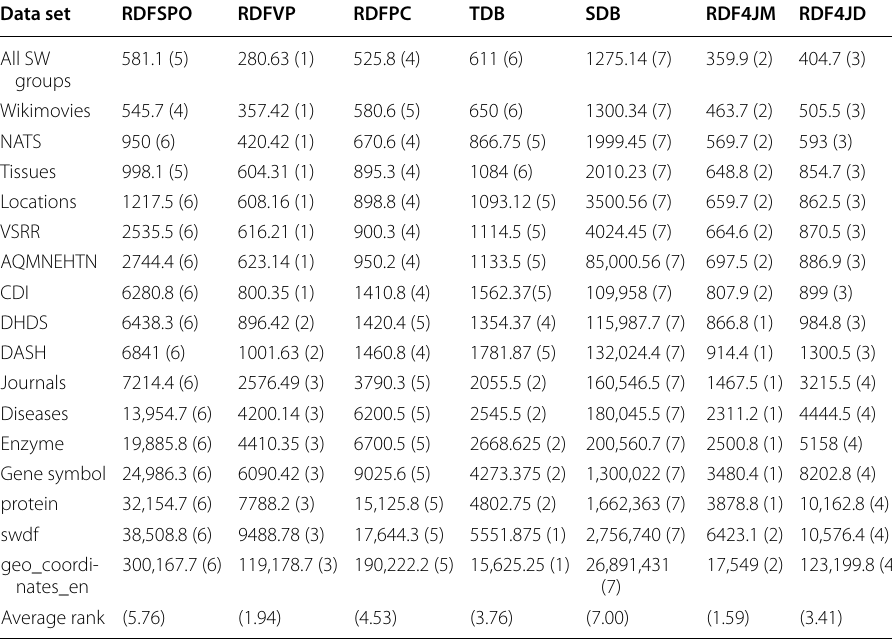
The ranks in the parentheses ( ⋅ ) are used in the computation of the Friedman